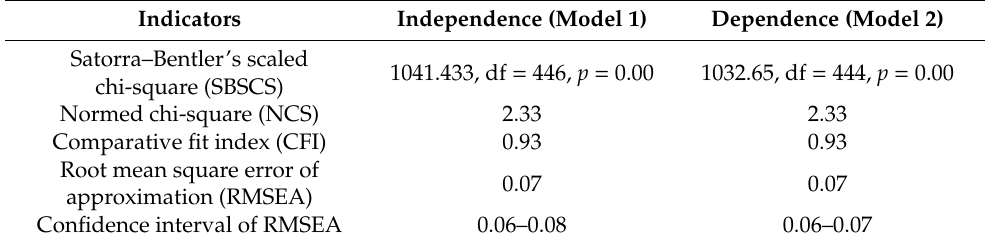
Table 5. Goodness of fit and entropy criterion for the hypothesized